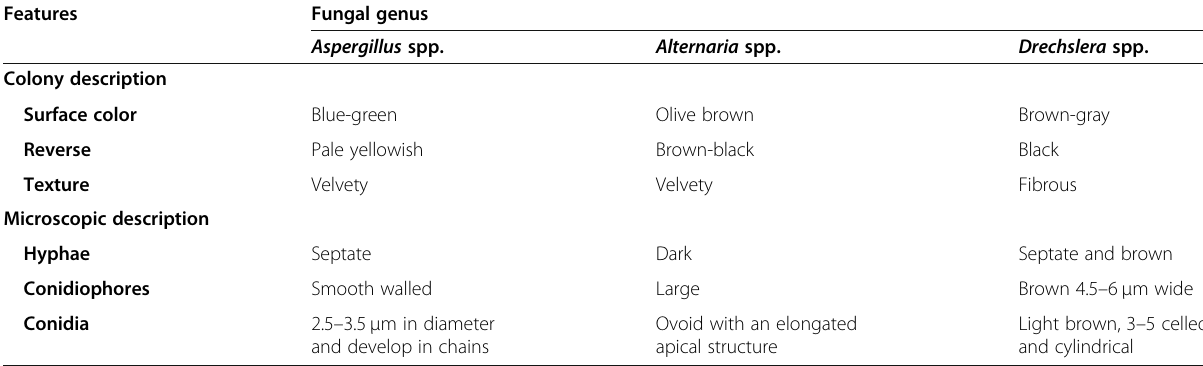
Table 1 Cultural and microscopic characteristics of endophytic fungi from Parthenium hysterophorus